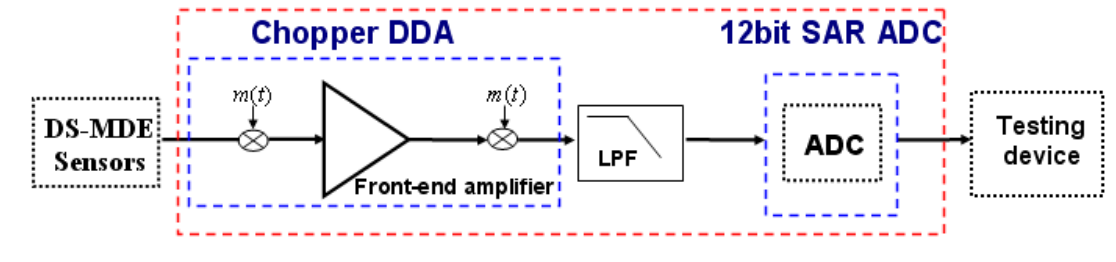
Figure 5. Block diagram of the proposed bio-potential acquisition